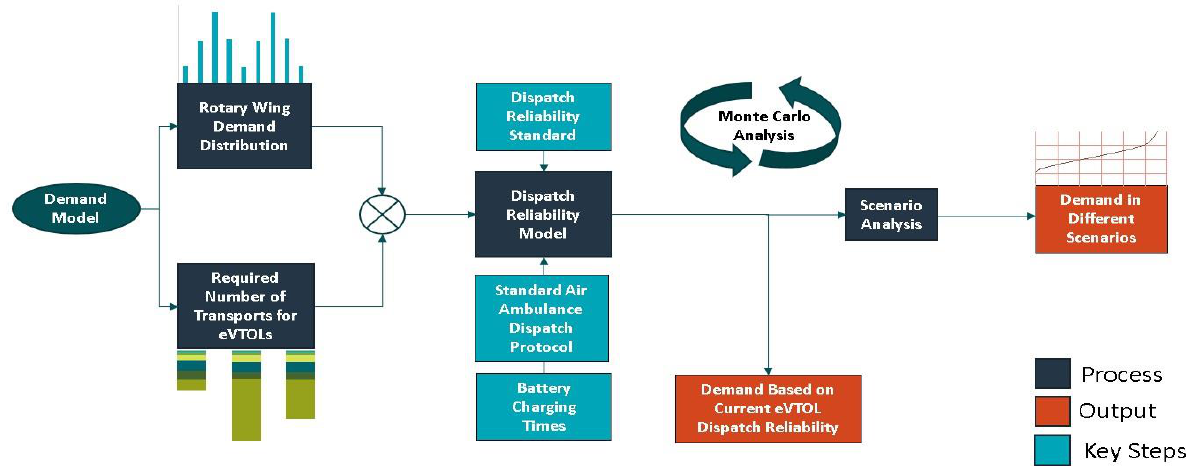
Figure 9. Demand model for air ambulances.